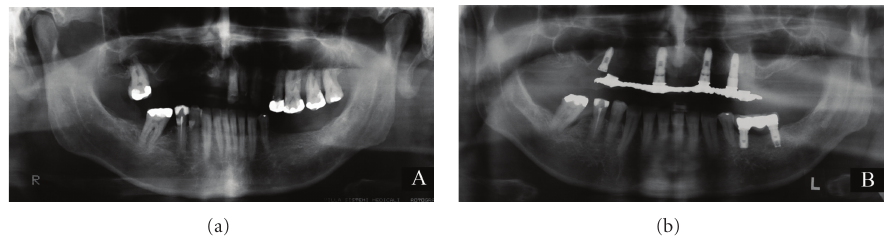
Figure 1: Panoramic radiographs of the patient. (a) Taken at the first visit. No bone alterations can be seen in the area of the lesion; (b) Nine- year follow-up: no change worthy of note.